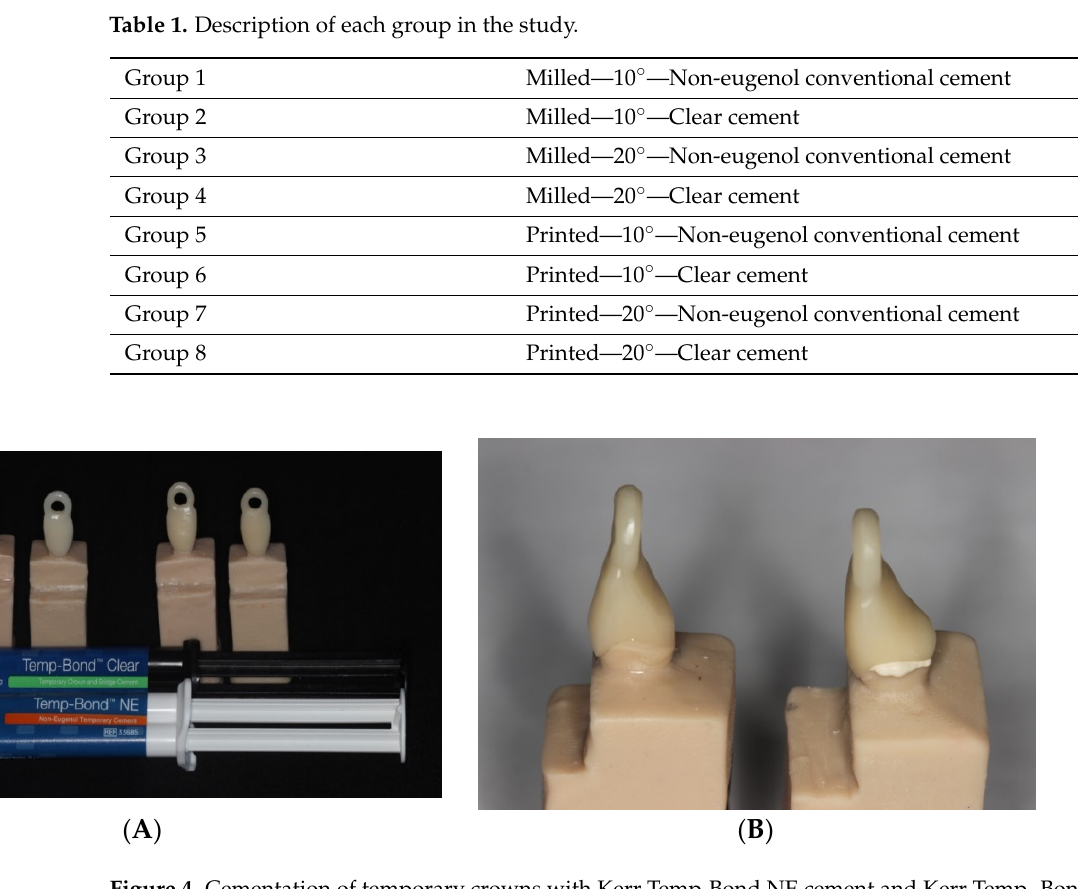
Figure 3. ( A ) STL file saved with the margin set-up and the cement space set-up. ( B ) CAD/CAM- milled temporary crowns and 3D-printed crowns on working models.